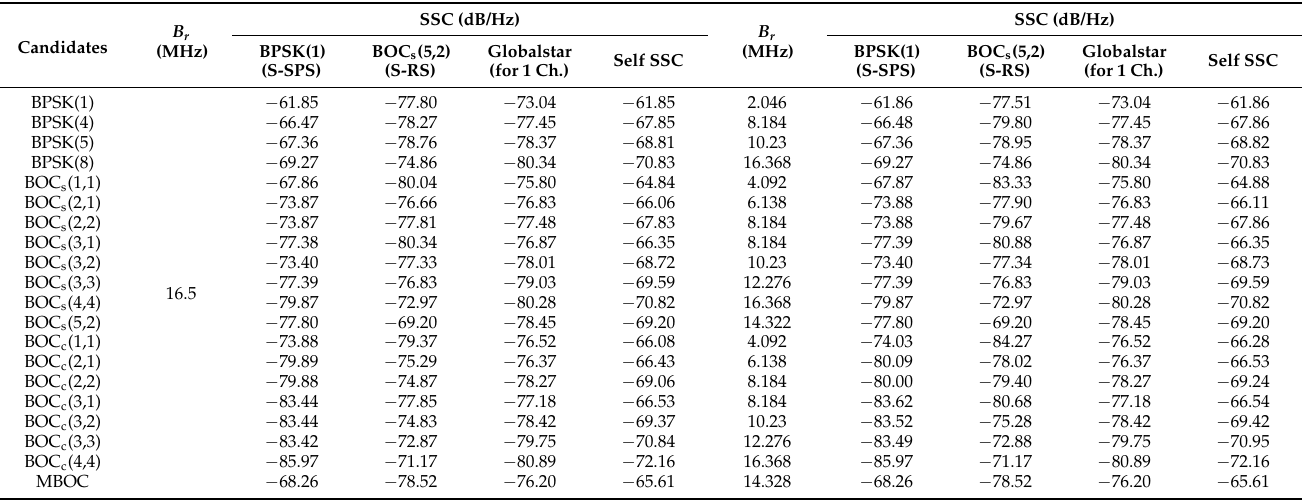
Table 4. Spectral separation coefficient (SSC) between existing signals and candidates: B r = 16.5 MHz or B r = 2 f c or 2( f s + f c ).